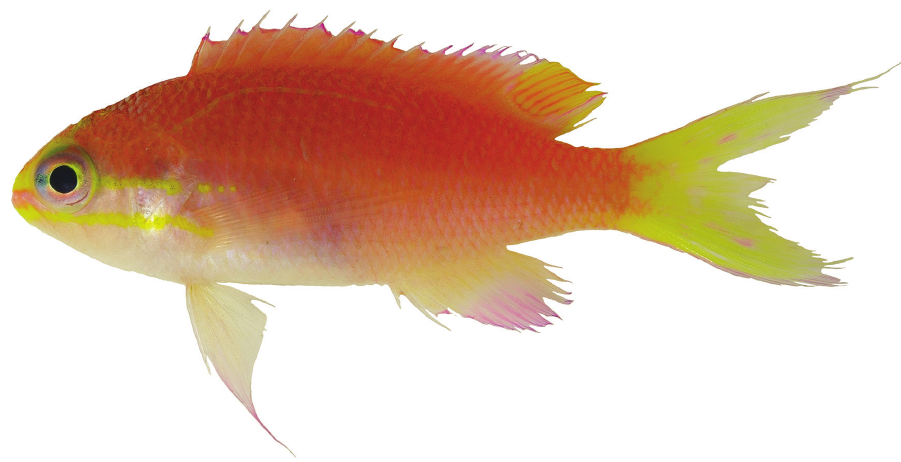
Figure 1. Holotype of Tosanoides obama (BPBM 41315), collected at a depth of 90 m off Kure Atoll, Northwestern Hawaiian Islands. Photo by R. L. Pyle.